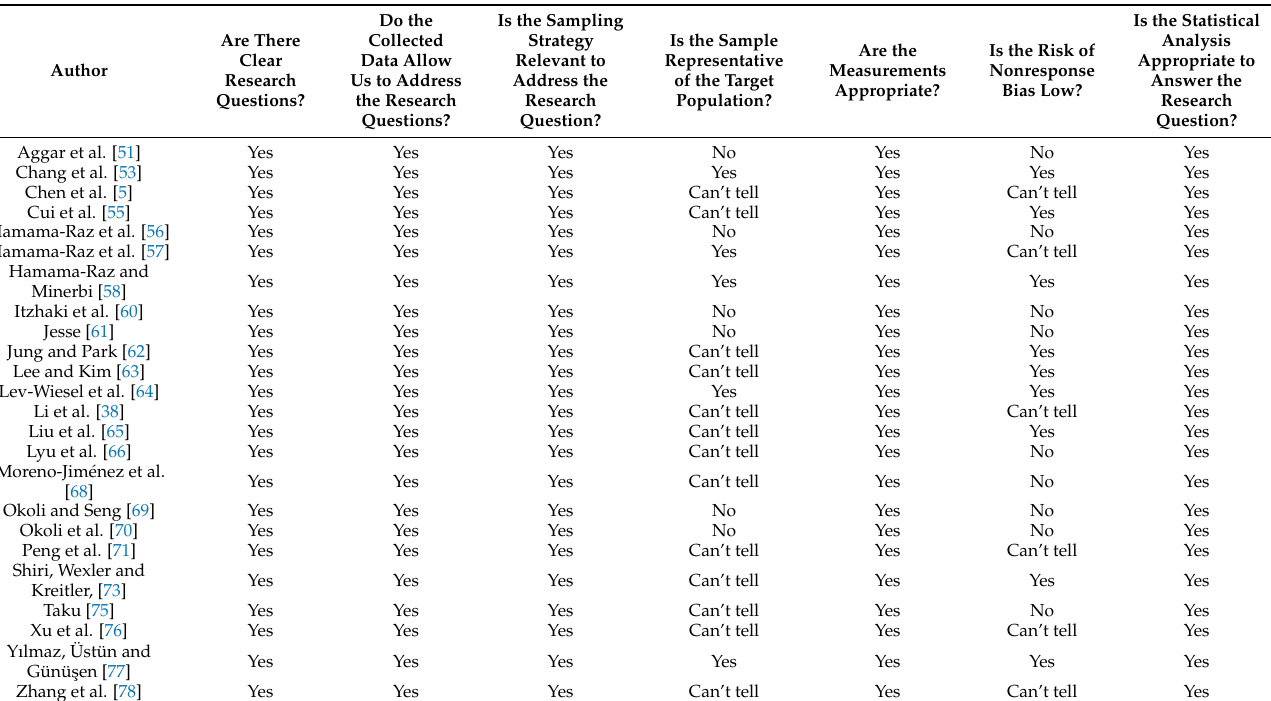
Table A3. Results of Mixed Methods Appraisal Tool (MMAT) Quantitative Descriptive Checklist.